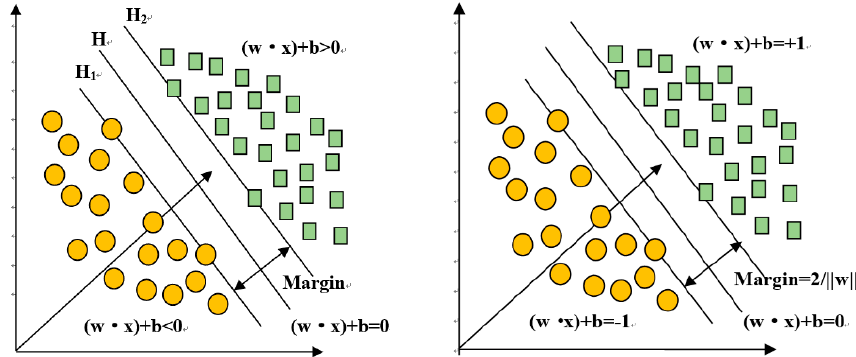
Figure 7. Optimal classified hyperplane (left) and Normalization Optimal classified hyperplane (right).